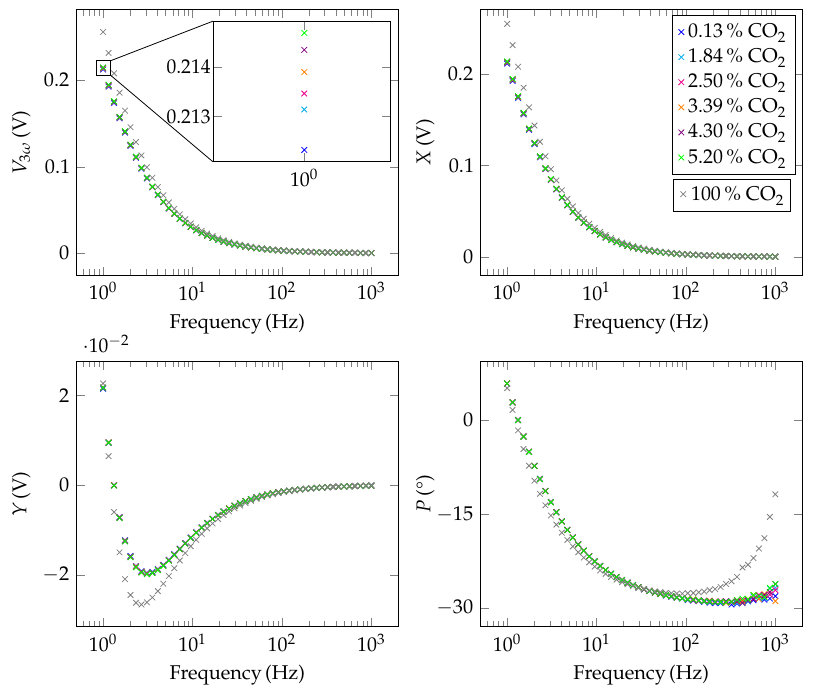
Figure 5. Raw 3-Omega signals (amplitude ( V 3 ω ), in-phase component ( X ), out-of-phase component ( Y ) and phase ( P )) for different concentrations of CO 2 in N 2 . Version December 21, 2021 submitted to Sensors